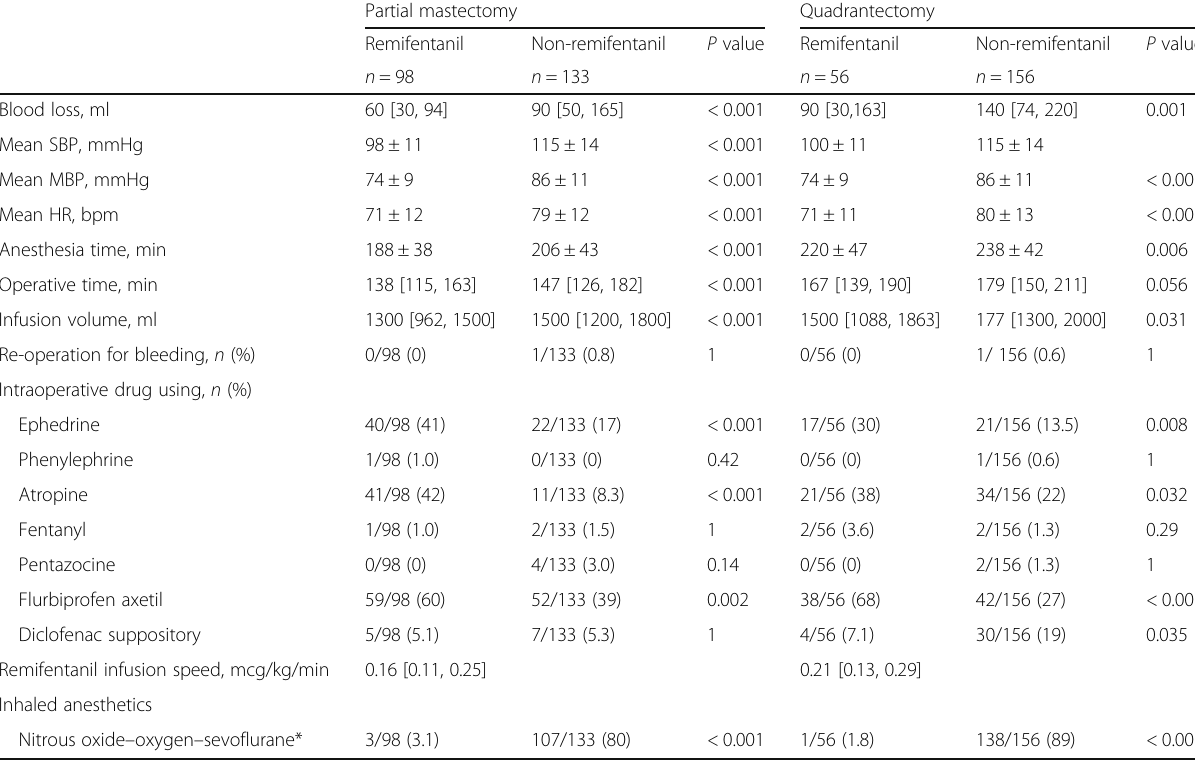
Table 2 Operative profile of mastectomies Partial mastectomy